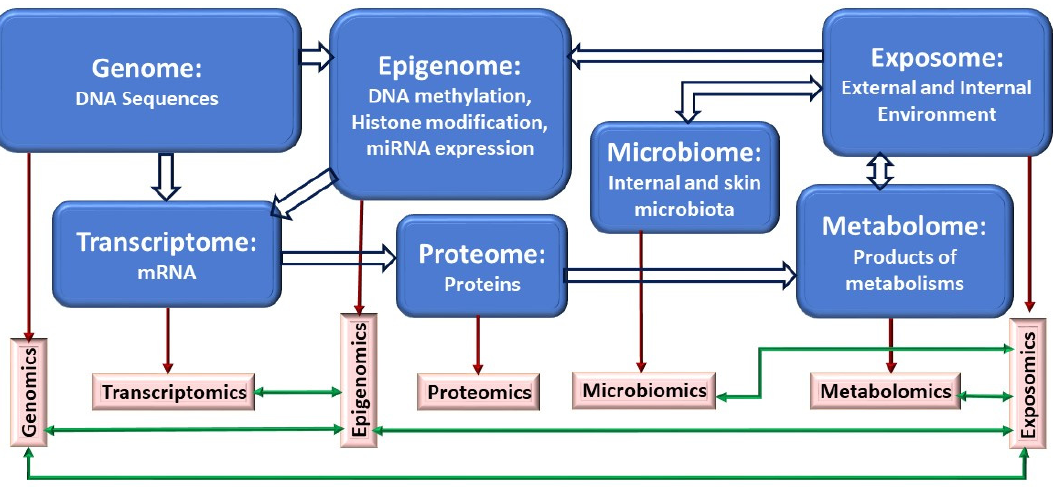
Figure 2. Schematic representation of relationships and interactions among types of biological molecules and their corresponding omics (top-down and bottom-up approaches). Block arrows indicate relationships between different classes of biological molecules, and green arrows represent potential interactions between omics datasets. One of the advantages of applying a multi-omics approach in biological systems is to understand the flow of information underlying disease and interpret the data in a holistic way in the context of biological networks and molecular interactions.